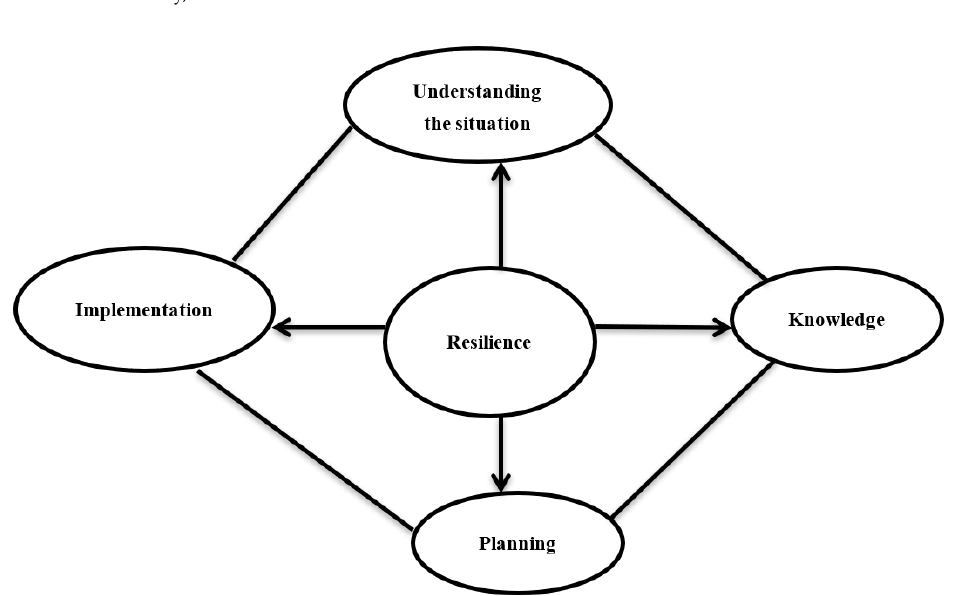
Figure 5. Adaptive resilient planning process, modified from Mengistu et al. [15].